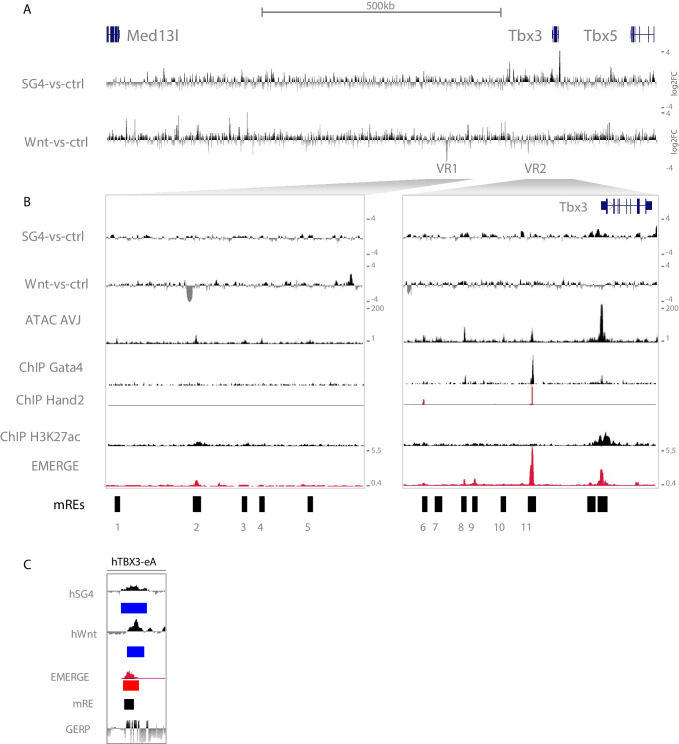
STARR-seq of the murine Tbx3/Tbx5 locus.(A) Overview of the murine Tbx3/Tbx5 locus with STARR-seq data tracks for mSTARR_SG4 (SG4-vs-ctrl) and mSTARR_Wnt (Wnt-vs-ctrl). The displayed tracks represent log2 fold changes of enrichment of SG4/Wnt-stimulated over the unstimulated control. (B) Zoom-in of VR1 and VR2 show overlap of mSTARR data tracks with tracks of ATAC-seq in embryonic AVJs, ChIP-seq for Gata4, Hand2 and H3K27ac, and EMERGE enhancer prediction. Black mRE bars below tracks depict final murine RE candidates selected based on signal in the different datasets. (C) Validated enhancer hTBX3-eA, previously shown to drive AVCS expression and to respond to SG4 stimulation in vitro (van Weerd et al., 2014), is conserved between human and mice (Genomic Evolutionary Rate Profiling; GERP), shows STARR-seq activity for both SG4 and Wnt stimulation (hSG4/hWnt), is predicted by human EMERGE, and is accessible in murine Tbx3+ AVCS cardiomyocytes (ATAC_AVCS; mRE).